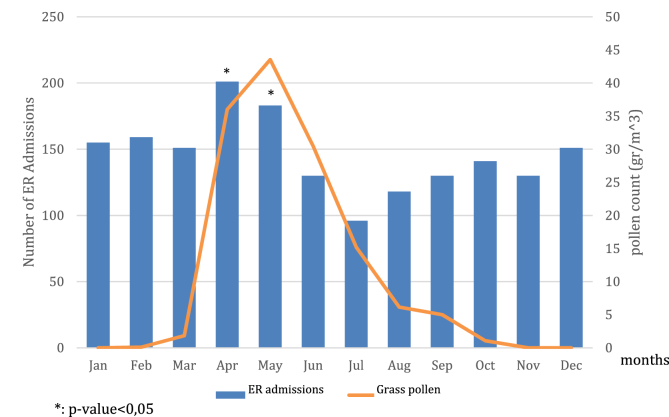
Trend of admissions during the whole year, paired with grass pollen count.